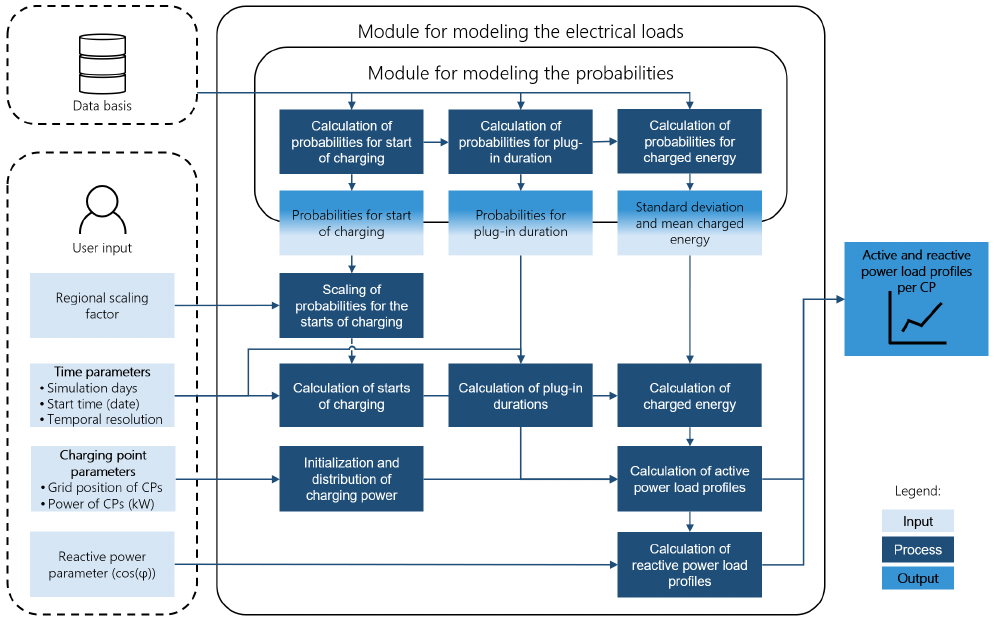
Figure 1. Schematic representation of the structural setup of the implemented model.